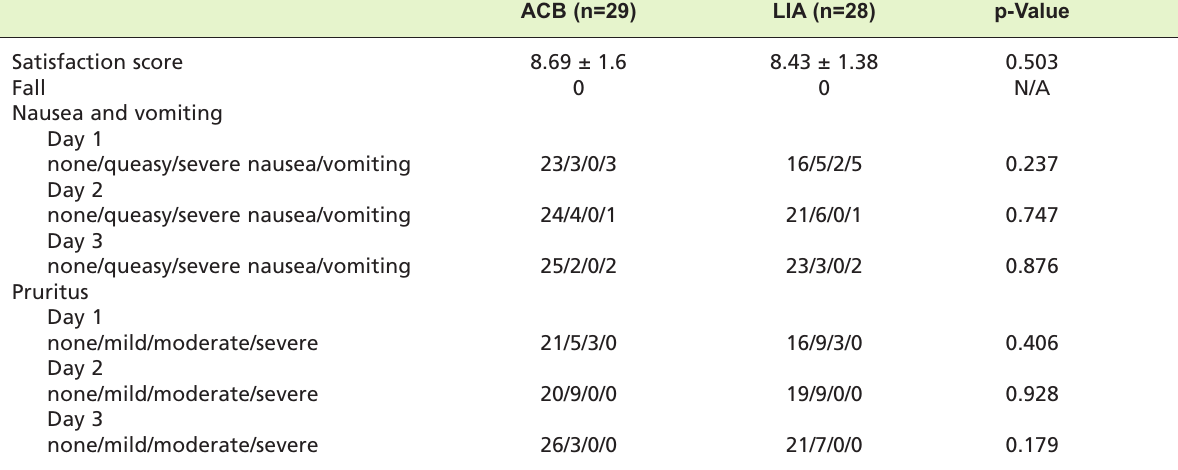
Patient satisfaction and adverse Table IV: